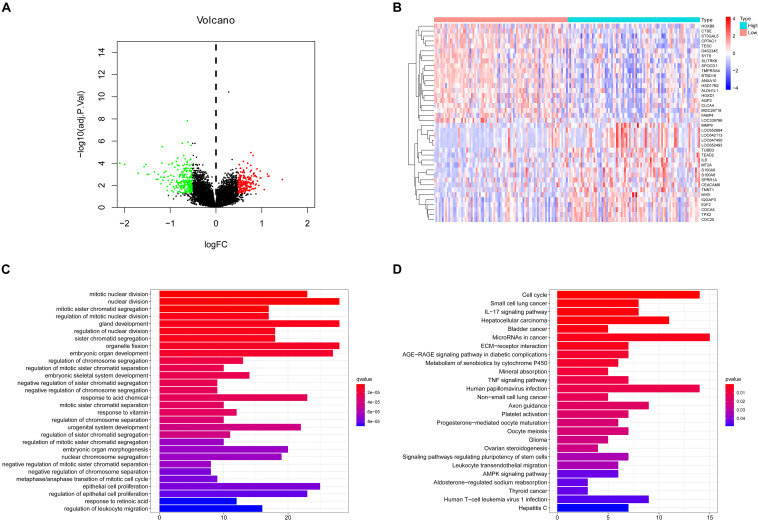
Different expression genes (DEGs), GO enrichment, and KEGG pathway analysis. (A) Volcano plot of the DEG expression between CNTD2high and CNTD2low. Cutoff criteria for DEG significance was P < 0.05 and the absolute value of the log2 fold change > 0.5. The red dots represent 211 upregulated genes, the green dots represent 246 downregulated genes, and black dots denote non-significant genes. (B) Heatmap demonstrates the top 20 upregulated genes and the top 20 downregulated genes. Red indicates high expression, white indicates intermediate expression, and blue represents low expression. (C,D) GO and KEGG analysis show different enriched pathways for differential expression genes.